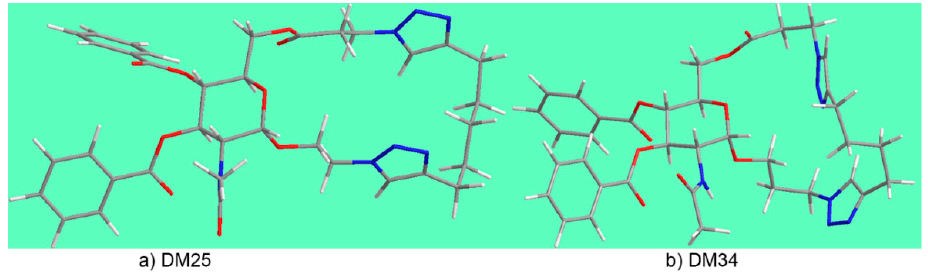
Figure 8. The energy minimized conformations of ( a ) DM25 and ( b ) DM34